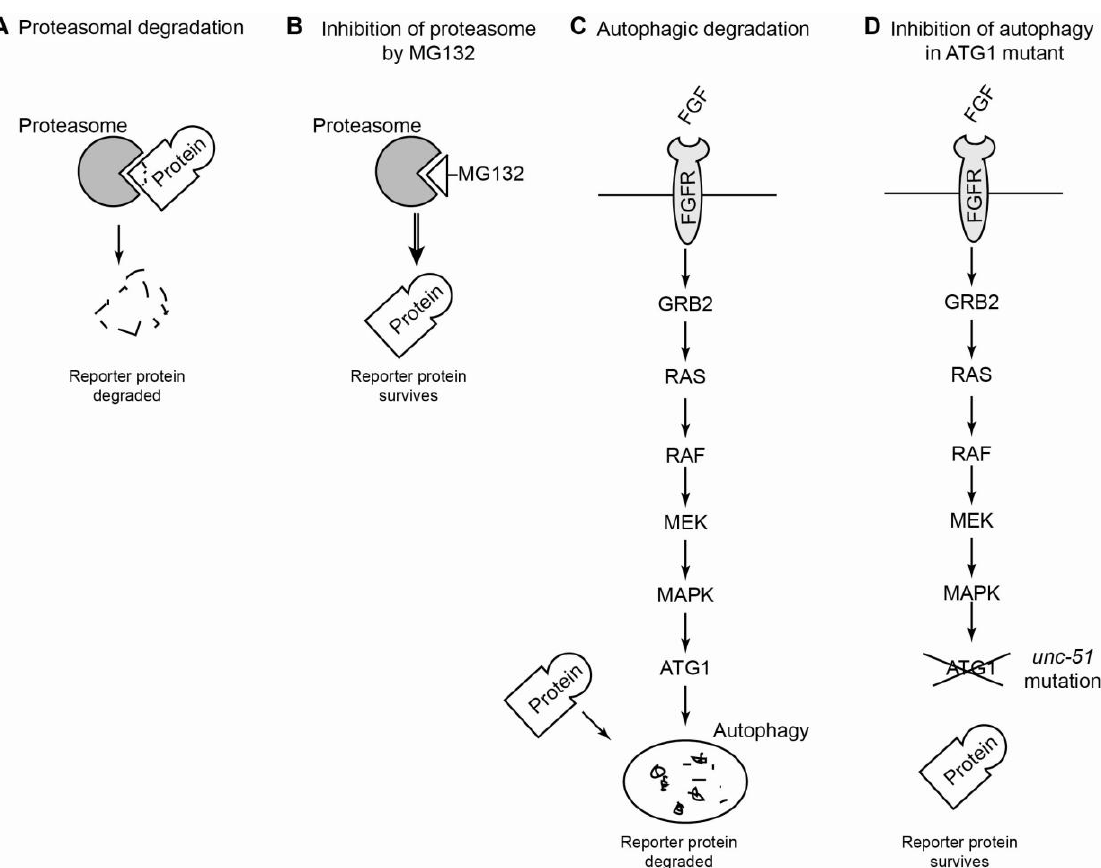
Figure 3. Examples of use of drugs and mutants to identify what protease is required for muscle protein degradation in response to RNAi against a gene of interest. (A) Schematic of a proteasome degrading a protein. (B) Schematic of a proteasome inhibitor blocking the ability of the proteasome to degrade a protein. (C) Schematic of Fibroblast Growth Factor (FGF) signalling inducing autophagy in C. elegans muscle [26 (cid:177) 28]. (D) Schematic of how a mutation in unc-51 blocks autophagy in response to FGF signalling [26,28] or signalling that impinges upon FGF signalling